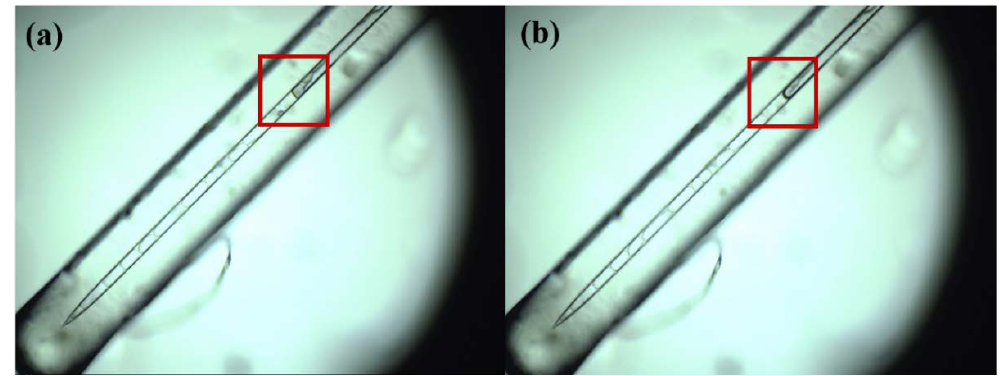
Figure 3. Images of a capillary tube filled with ultrapure water placed on the cold stage. ( a ) Water